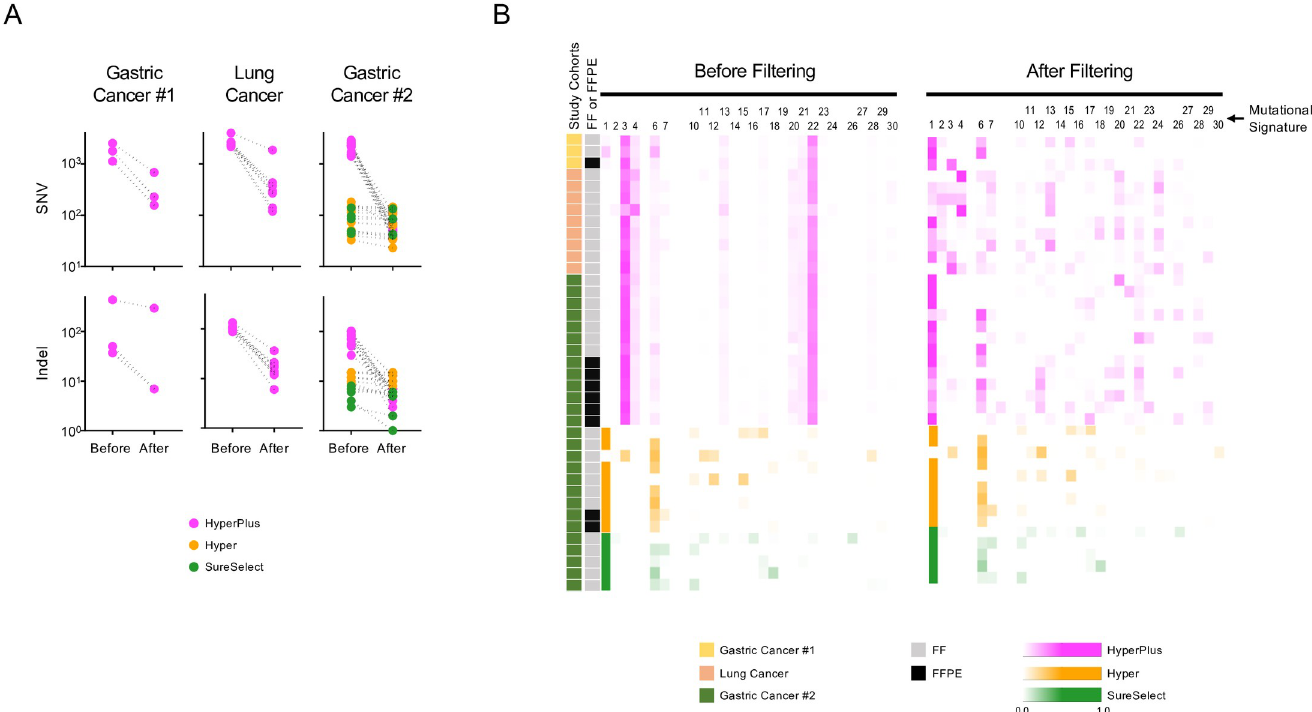
Fig 6. Noise reduction in the test data. Changes in the features of the somatic variants detected before and after noise filtration for each sample. Libraries were prepared with KAPA HyperPlus (enzymatic fragmentation), KAPA Hyper (ultrasonic fragmentation), or Agilent SureSelect (ultrasonic fragmentation) kits. Note that the only difference between the HyperPlus and Hyper kits is that the Hyper kit uses ultra-sonication in the DNA fragmentation step, whereas endonuclease treatment is used in the HyperPlus kit. (A) Dot plots show changes in the numbers of SNVs (upper panels) and indels (lower panels) for each sample, with libraries prepared with HyperPlus (magenta), Hyper (orange), or SureSelect (green) kits. (B) Heatmap presentations of mutational signatures before and after noise filtration for each sample. Libraries were prepared with HyperPlus (magenta), Hyper (orange), or SureSelect (green) kits. The heatmap represents the proportions of the 30 COSMIC mutational signatures [9] computed from trinucleotide frequencies of nucleotide substitutions in each sample. The number above the heatmap indicates each of the 30 signatures computed according to the definitions in the COSMIC database. The study cohorts and tissue preservation types are indicated on the